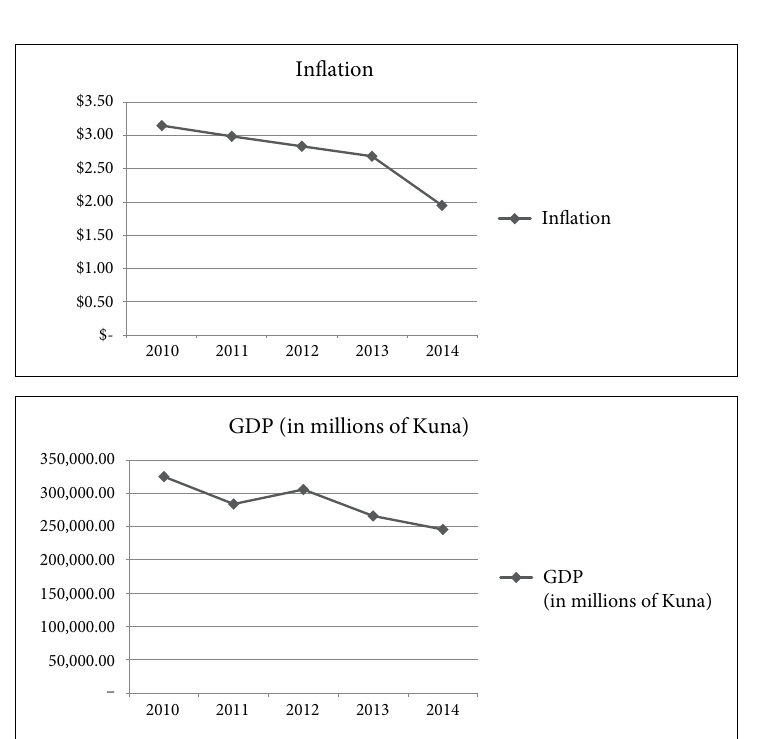
Fig. 4. Scenario of the reduction in the level of inflation and the impact on GDp. Source: autors calculation